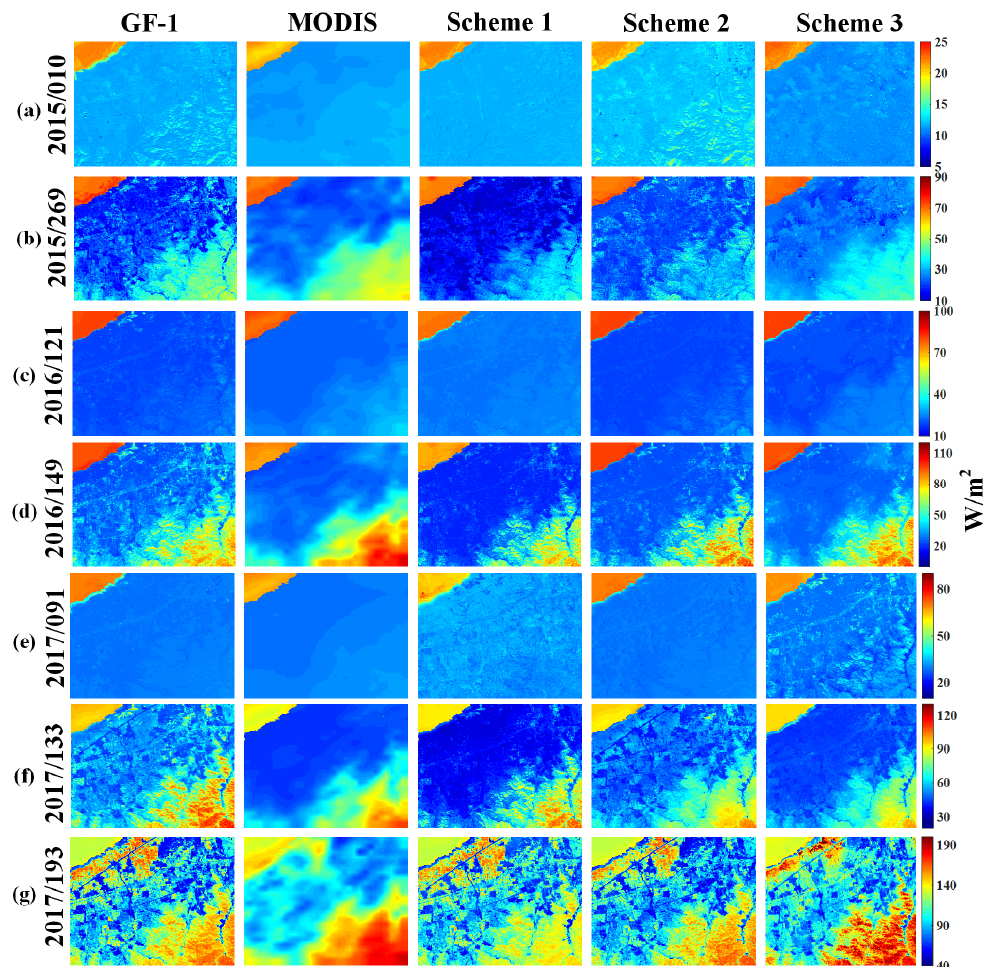
Figure 5. Spatial comparison of three fusion schemes estimated LE with the corresponding GF-1 and MODIS LE on the GF-1 available validation dates. The column order from the left to right: (1) actual reference GF-1 LE, (2) MODIS LE, (3) estimated LE for Scheme 1, (4) estimated LE for Scheme 2, (5) estimated LE for Scheme 3. The row order from the top to bottom: ( a ) 2015 / 010, ( b ) 2015 / 269, ( c ) 2016 / 121, ( d ) 2016 / 149, ( e ) 2017 / 091, ( f ) 2017 / 133, ( g ) 2017 / 193 (in Year / DOY